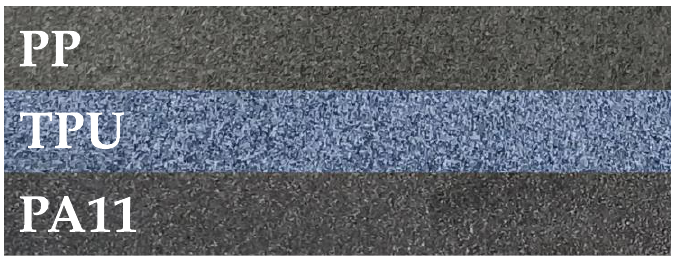
Figure 6. Surface structure for the different types of material.